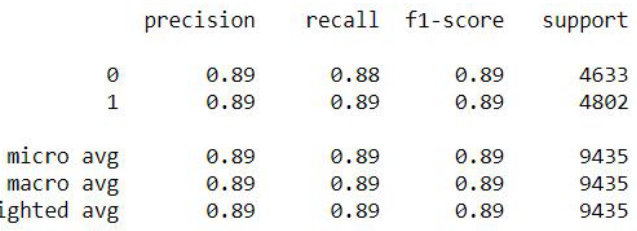
Figure 12. Binomial Logistic Regression metrics.